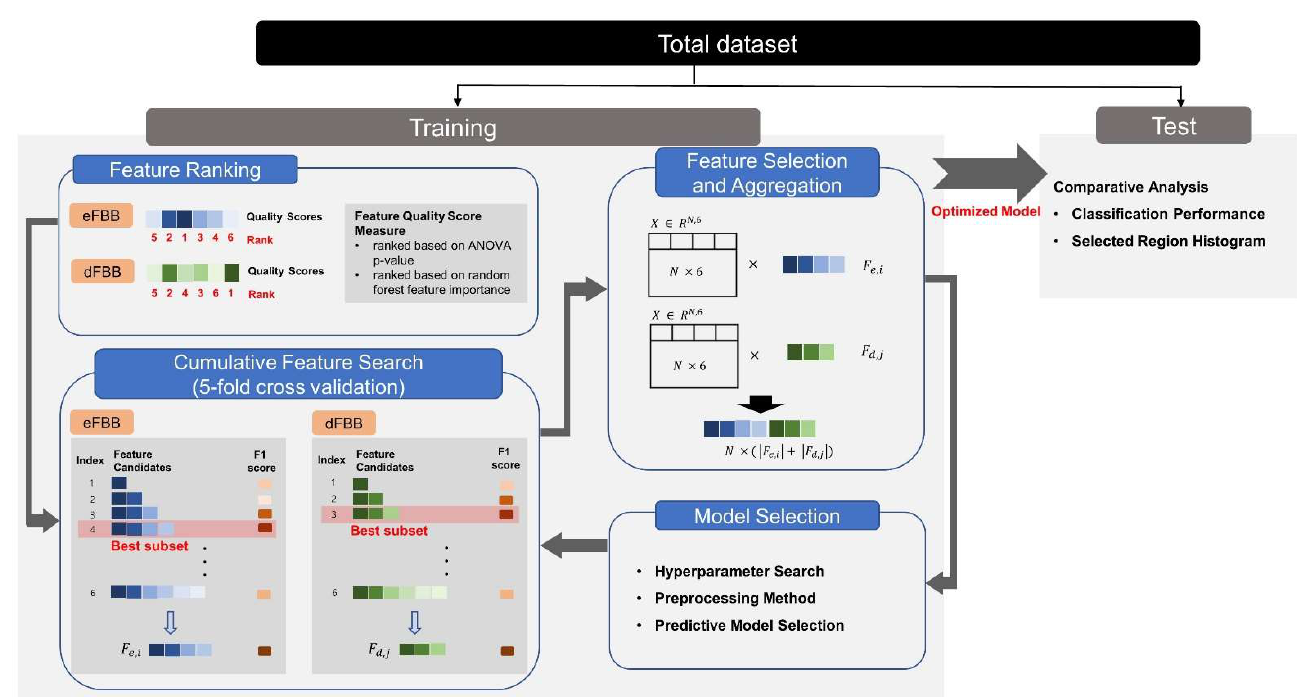
Figure 4. Overview of the proposed framework to make the feasibility of AD classification with dual FBB. eFBB: early-phase FBB, dFBB: delay-phase FBB, dual FBB: dual-phase FBB, CV: cross validation, F e , i : best feature combination of eFBB, F d , j : best feature combination of dFBB. F e , i and F d , j are used to filter raw data, and the filtered data are used as independent variables for predictive models in the model selection and evaluation.